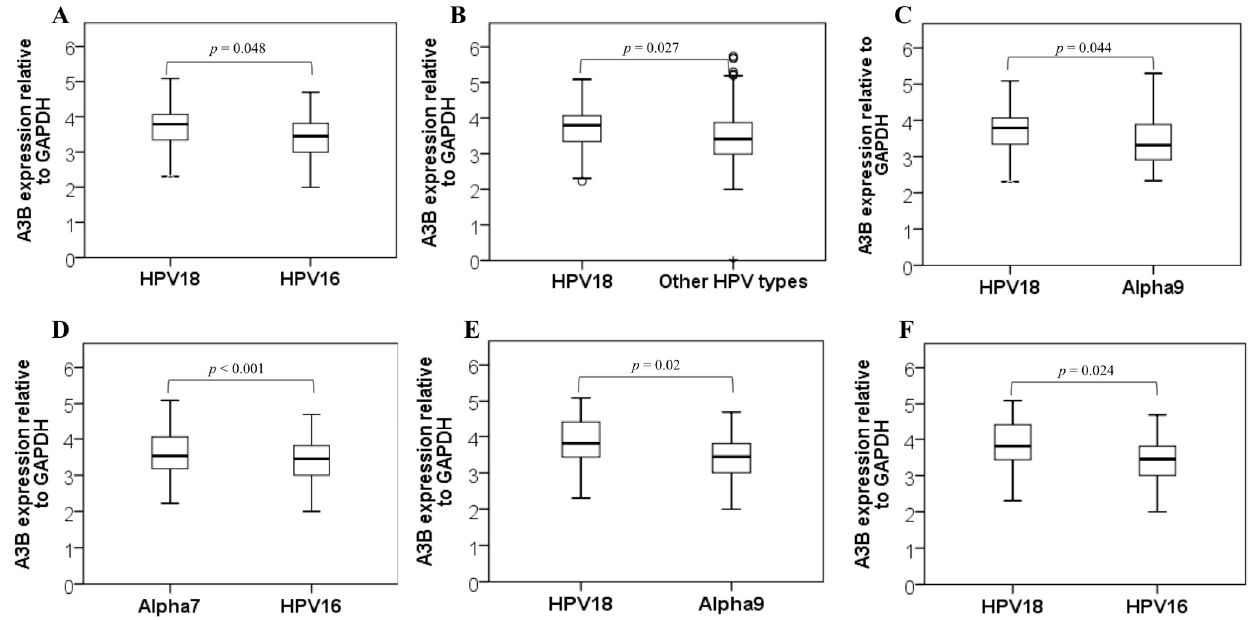
Figure 1. APOBEC3B mRNA expression relative to GAPDH in cervical cancer samples comparing ( A ) HPV18 and 16; ( B ) HPV18 and all other HPV types; ( C ) HPV18 and Alpha-9 species; and ( D ) HPV16 and Alpha-7 species ( D ; p < 0.001). APOBEC3B mRNA expression relative to GAPDH in squamous cell carcinoma (SCC) samples comparing HPV18 + with Alpha-9 species ( E ) and with HPV16-infected women ( F ).